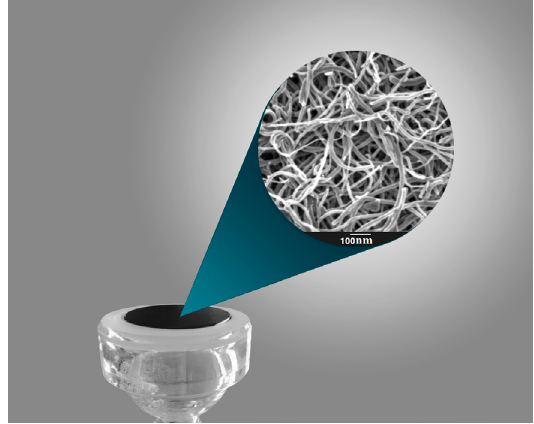
Figure 1. Buckypaper (BP) supported by a microporous membrane after vacuum